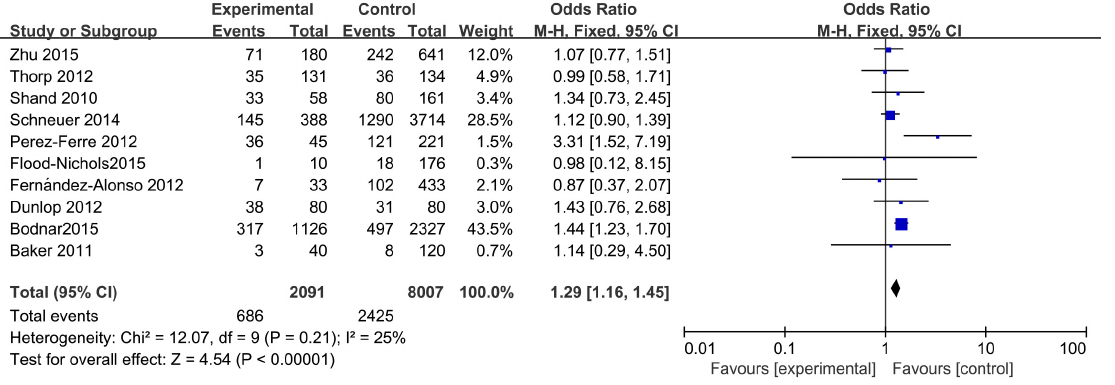
Figure 2. The meta ‐ analysis of the association between maternal vitamin D deficiency and PTB. Figure 2. The meta-analysis of the association between maternal vitamin D deficiency and